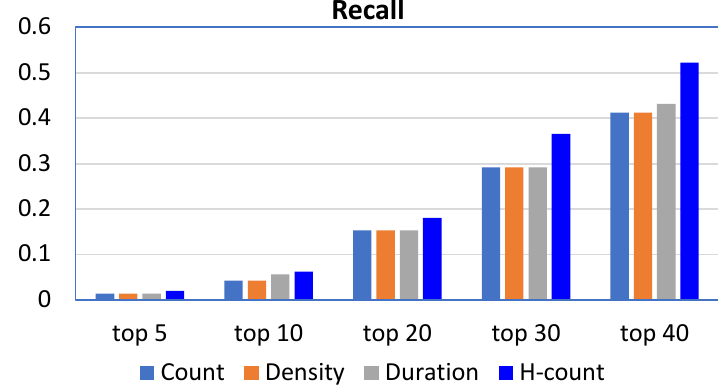
Figure 3. Recall comparison between H-Count and three baselines.